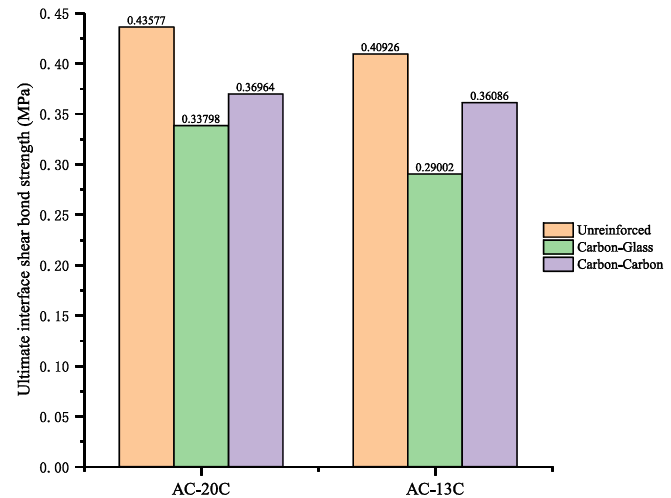
( b ) Figure 3. The direct shear and oblique shear apparatus: ( a ) the direct shear apparatus; ( b ) the oblique